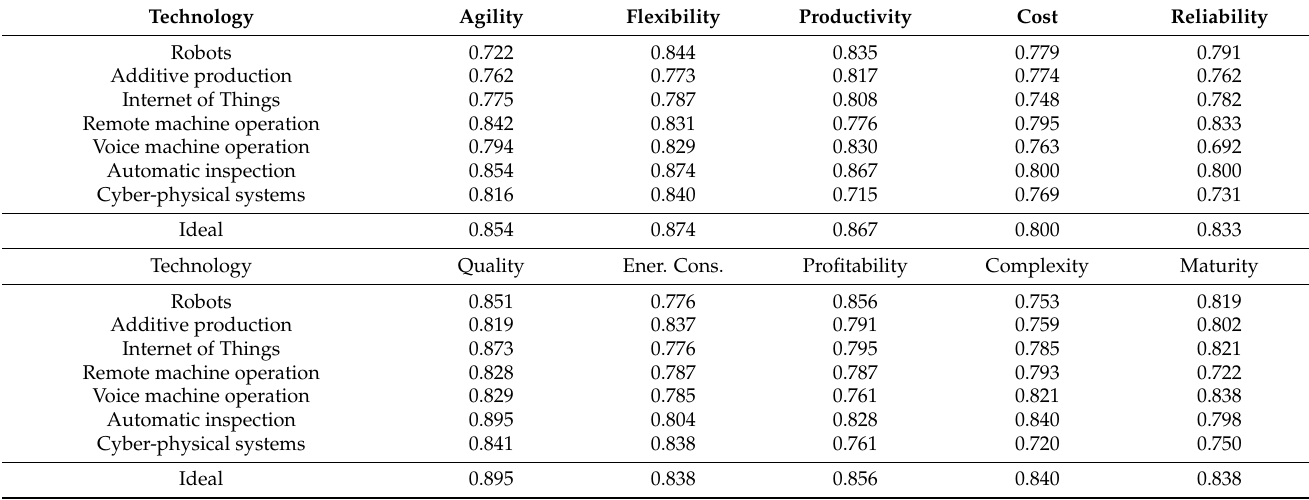
Table A8. The utility matrix of weighted geometric sequence.